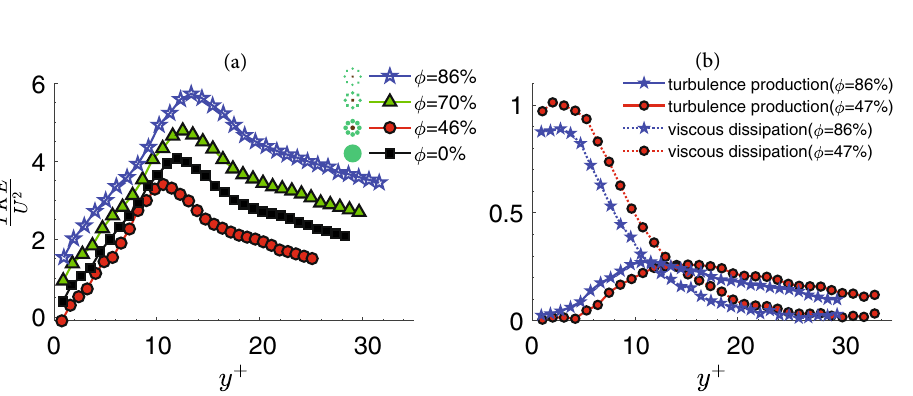
Figure 9. Variations of spatially-averaged of flow parameters with non-dimensional wall-normal distance behind the models. ( a ) Turbulent kinetic energy budget. ( b ) Turbulence production versus viscous